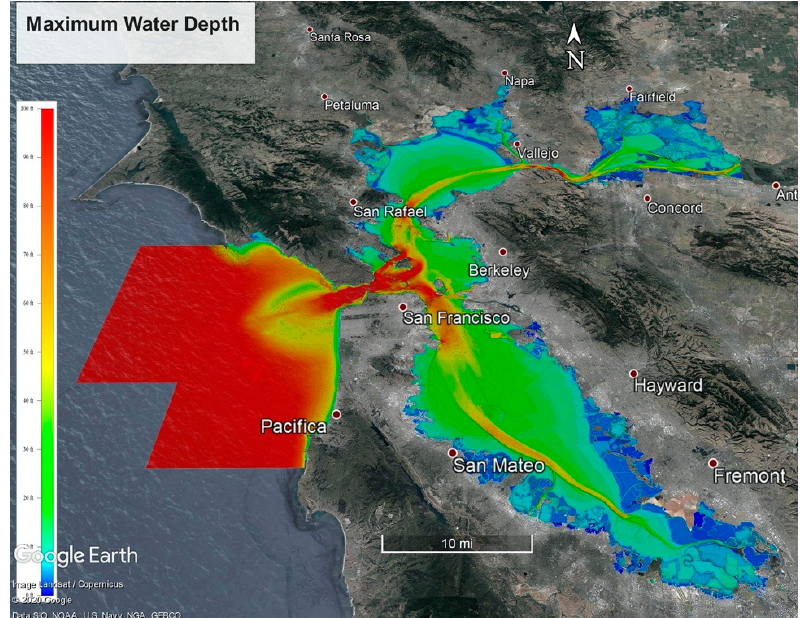
Figure 9. Hydro-CoSMoS display of simulated maximum water depth in San Francisco Bay for the scenario described in the text.